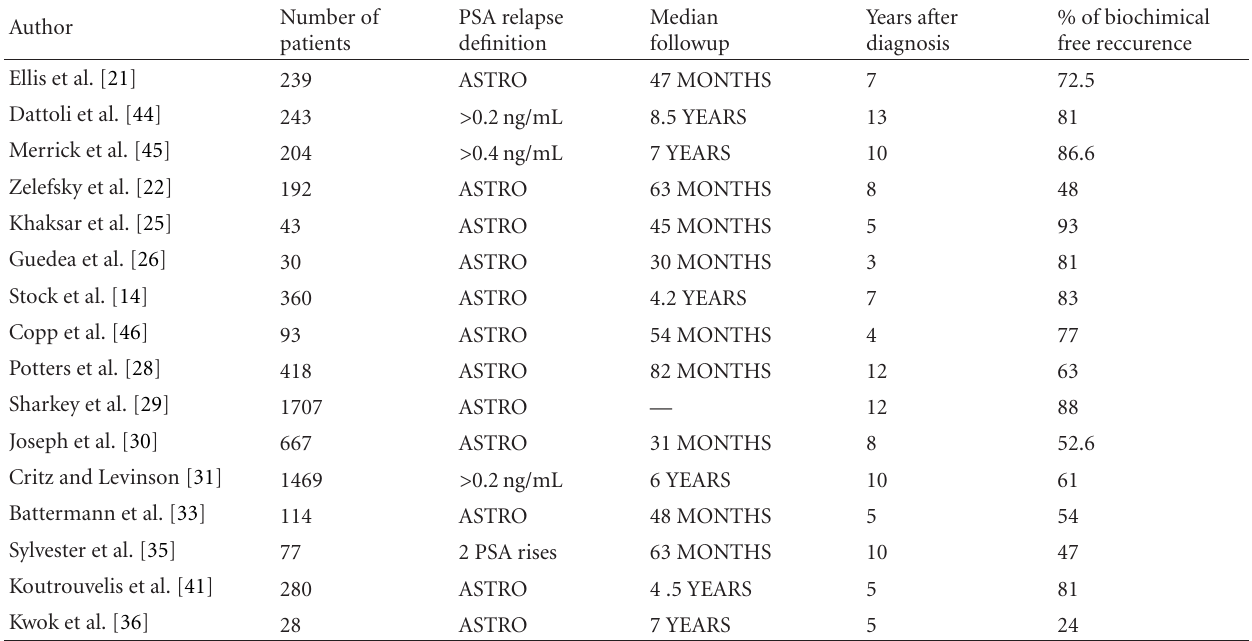
Table 3: LDR brachytherapy: clinical results for patients with high-risk prostate cancer treated with combined brachytherapy and androgen deprivation or external-beam radiation